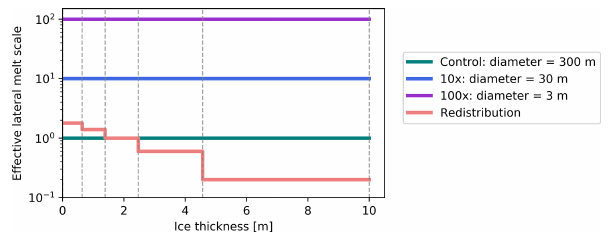
Figure 2. Summary of lateral melt rates for all sensitivity runs. Ver- tical dashed grey lines indicate bounds of the five ice thickness dis- tribution categories. Solid lines show the effective lateral melt rate scale, relative to a value of 1 for the default parameterization. De- creasing the floe size D and increasing the scale r n have the same effect, such that the effective lateral melt rate scale can be summa- rized as r n , where 300 is default floe D/ 300